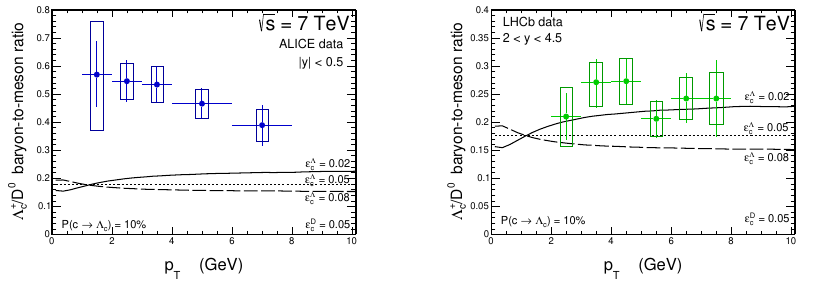
Figure 13. Transverse momentum dependence of the Λ c / D 0 baryon-to-meson ratio for ALICE (left) and LHCb (right) for di ff erent choices of the ε Λ fragmentation